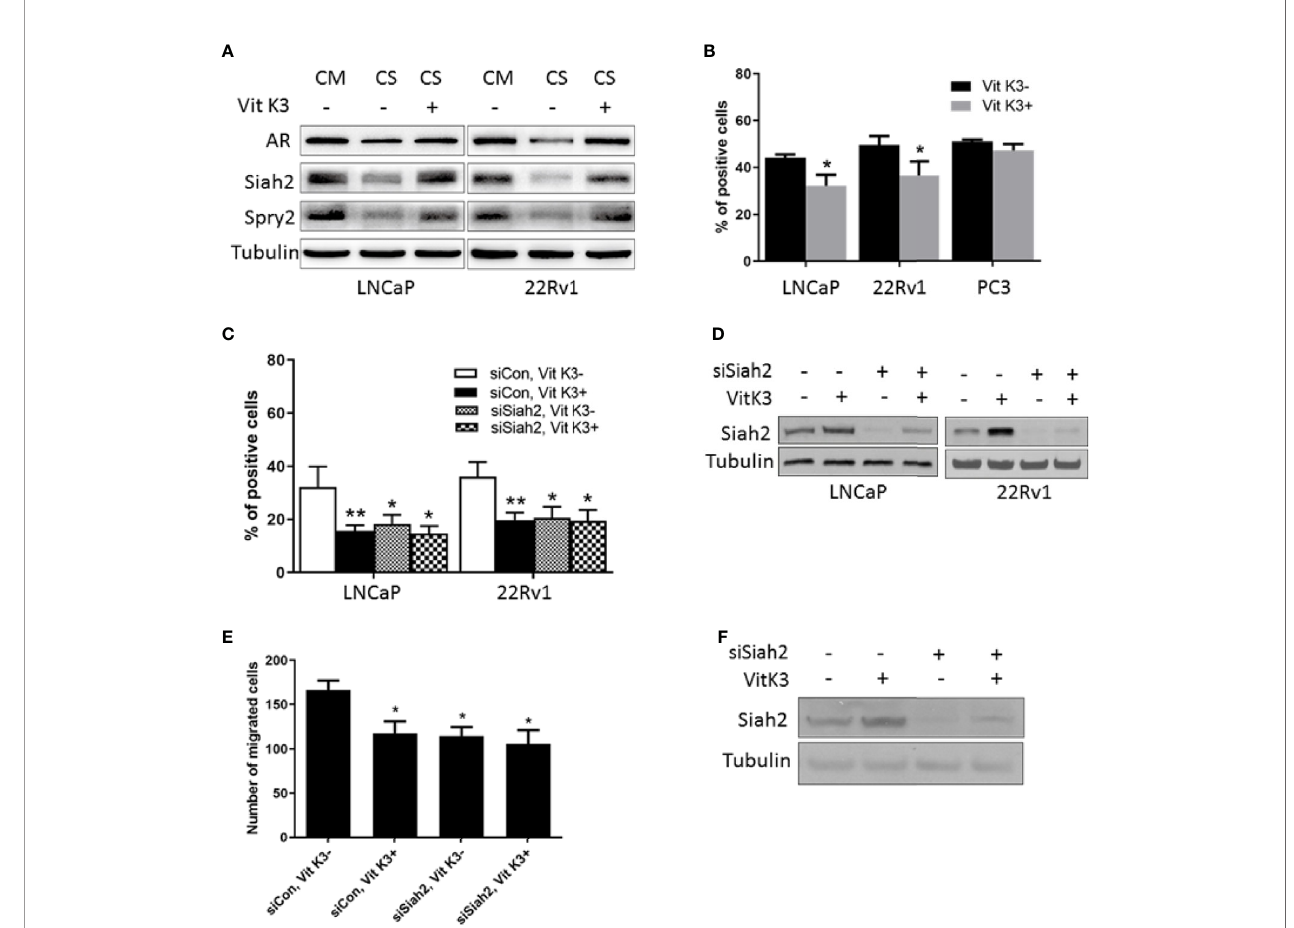
FIGURE 4 | Vit K3 attenuated the effects of ADT on Siah2. (A) LNCaP and 22Rv1 cells were cultured in CS-FBS medium for 24 h, and then treated with Vit K3 (20 m M) for 24 h. Spry2, Siah2, and AR protein expression were detected by Western blotting. (B) LNCaP, 22Rv1, and PC3 cells were treated with Vit K3 (20 m M) for 24 h, and then treated with 10 m M BrdU for 5 h (LNCaP) or 2 h (22Rv1, PC3, and DU145). The BrdU assay was performed as described in the Materials and Methods. (C) LNCaP and 22Rv1 cells were transfected with siRNAs targeting Siah2 or control as indicated for 72 h, and then treated with Vit K3 (20 m M) or vehicle as indicated for 24 h. BrdU assays were performed as described in (B) . (D) The expression of Siah2 protein from cells treated as described for C was detected by Western blotting. (E) LNCaP cells were transfected with si-Siah2 or si-control as indicated, and then cultured in transwell chambers, as described in the Materials and Methods. Cells were then treated with Vit K3 (20 m M) or vehicle for 24 h, and subsequently were stained with crystal violet, after which the number of cells per fi eld was quanti fi ed. (F) The expression of Siah2 protein from cells treated as described for E was detected by Western blotting. *P < 0.05; **P <